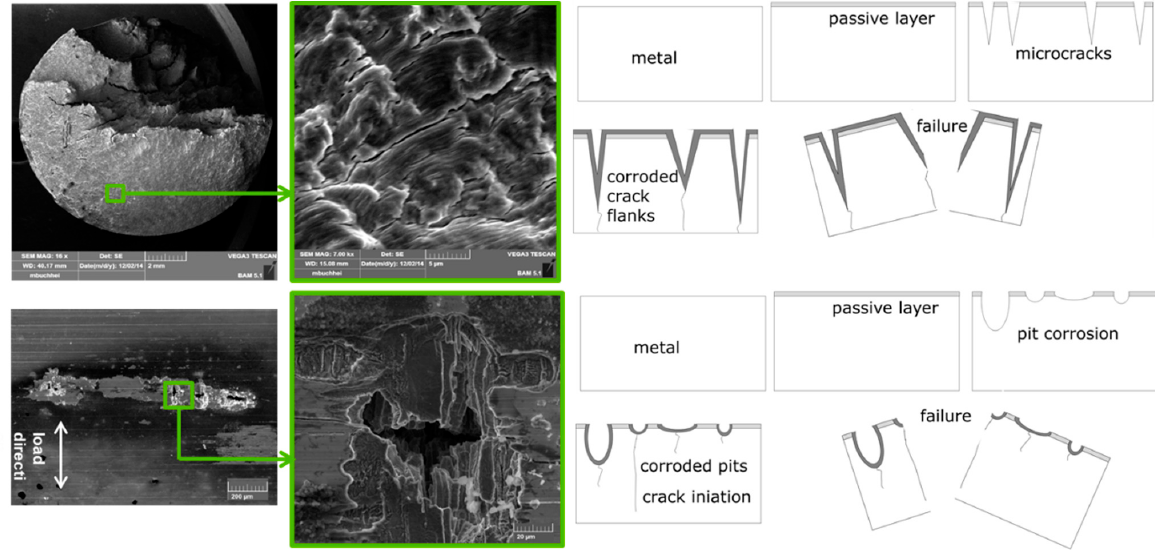
Figure 19. Schematic S-N curves of 1.4462 X2CrNiMoN22-5-3 in air and the corrosive media Northern German Basin at 98 °C after machine turning (technical surface) and polishing (polished surface).